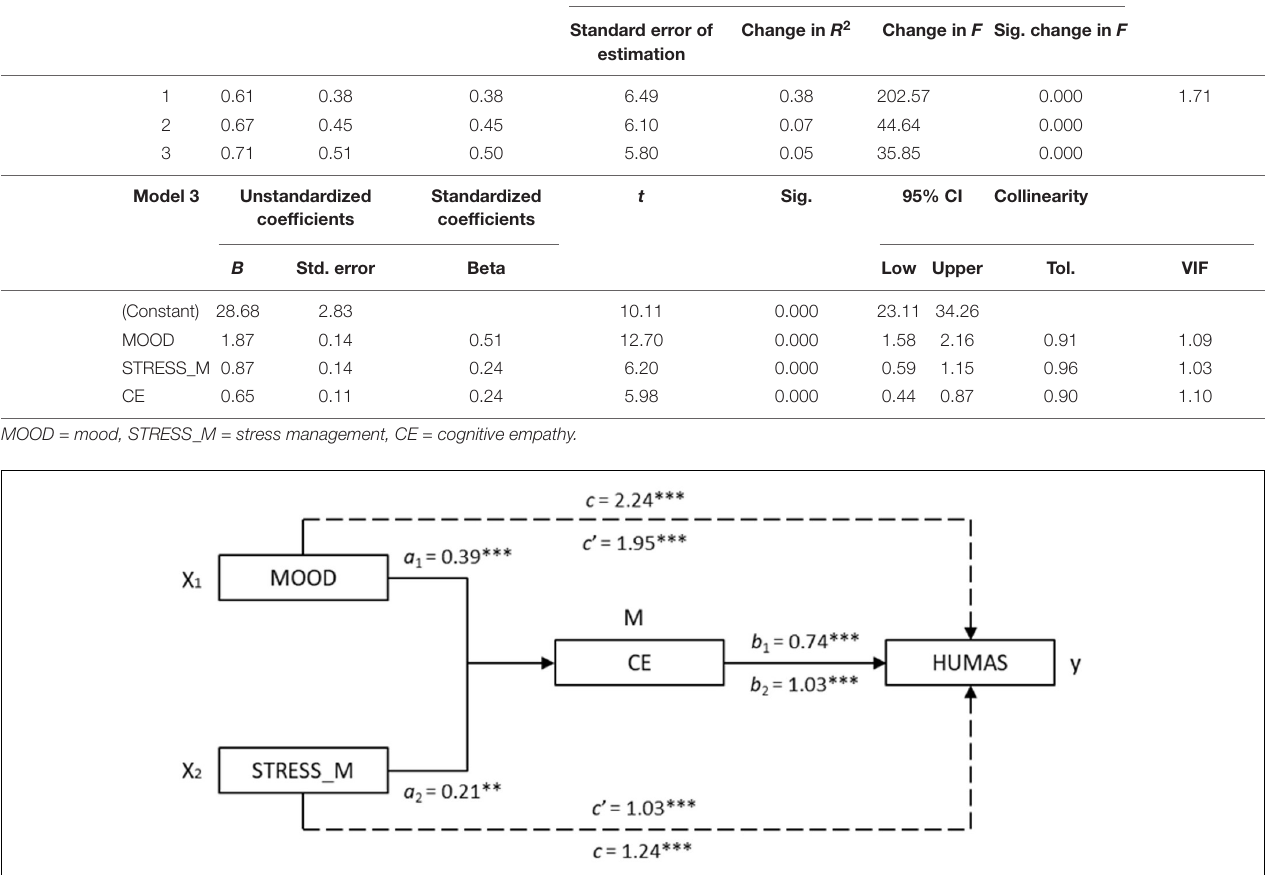
TABLE 3 | Stepwise multiple linear regression model. Humanization Model